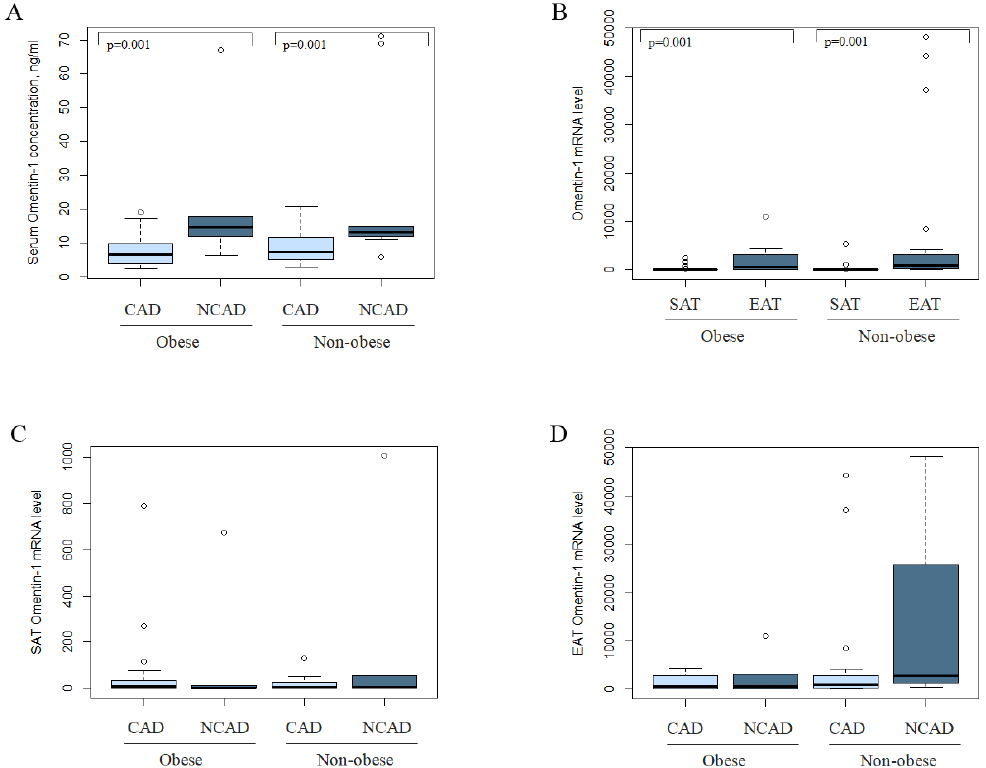
Figure 2 ‒ Omentin-1 serum concentration (A) and gene expression in adipose tissue in obese and non-obese subgroups: comparative analysis of the omentin-1 gene expression in subcutaneous and epicardial fat depots (B); omentin-1 mRNA level in subcutaneous (C) and epicardial adipose tissue (D) in CAD and NCAD